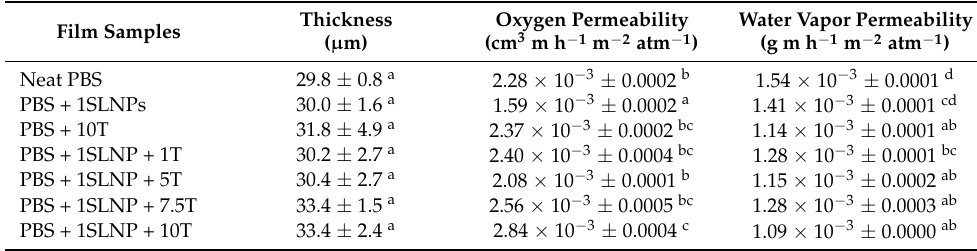
Table 4. Thickness, OP, and WVP of neat PBS and PBS composites